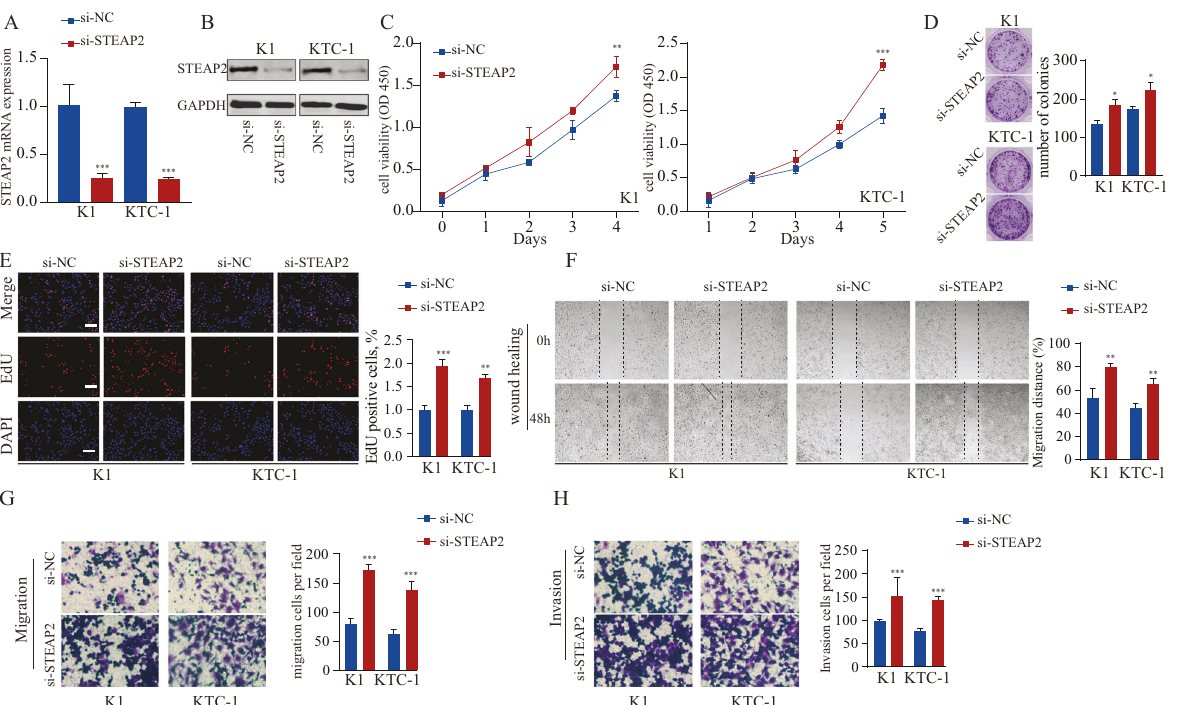
Fig. 3 Loss-of-function of STEAP2 inhibits the proliferation and migration of PTC cells. A-B The knockdown effect on STEAP2 was detected by RT-qPCR and western blot after transfection of K1 and KTC-1 cells with designed siRNAs targeting STEAP2 (si-STEAP2) or negative control (si-NC). C – E CCK-8 assay, colony formation assay, and EdU assay were used to determine the viability of BCPAP and TPC-1 cells after STEAP2 silencing. Scale bar: 50 μ m. F – H Wound healing assay, transwell migration assay, and transwell invasion assay were performed to evaluate the migration ability of K1 and KTC-1 cells after STEAP2 activation. All data are presented as the mean ± standard deviation of three independent experiments. * P < 0.05, ** P < 0.01, and *** P <